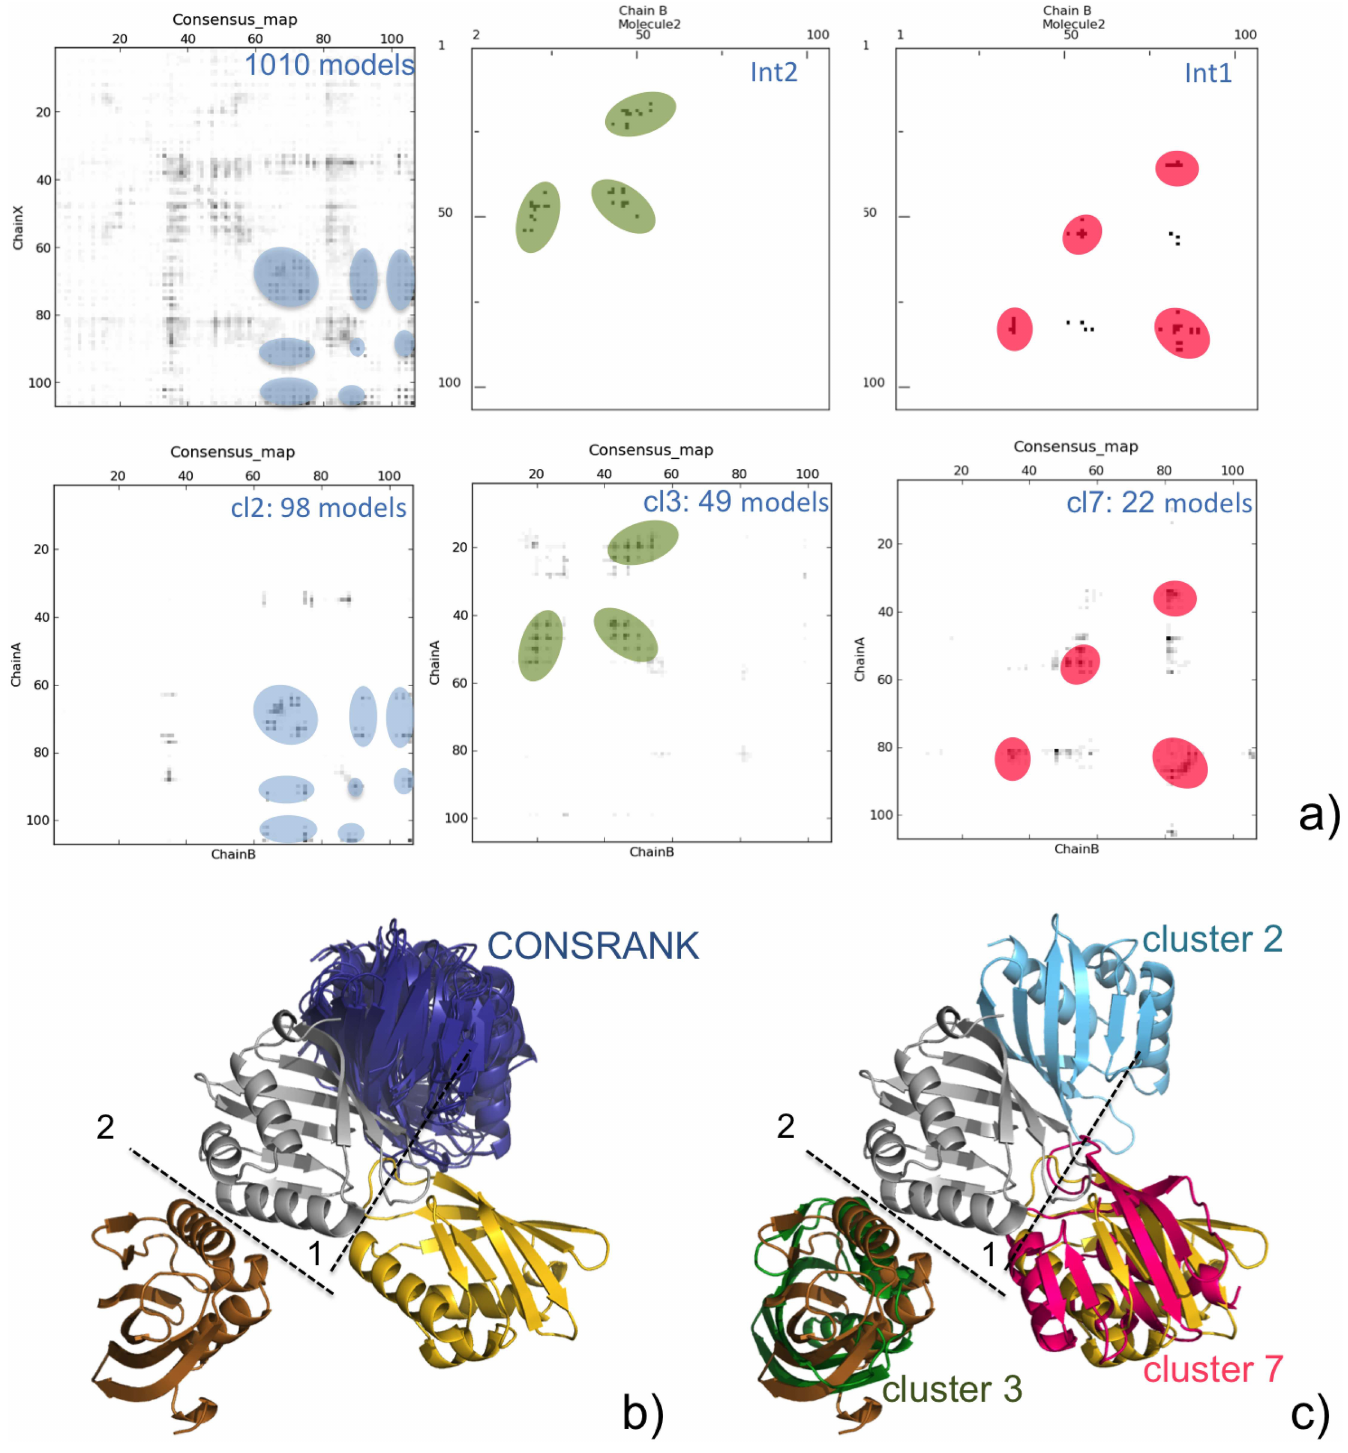
Fig 3. T86 scoring. (a) Consensusmap (from the 1010 models) and contact map of the two target assessedinterfaces (above) and consensus maps from the models in the 2 nd , 3 rd and 7 th MC /10 clusters (below).Regionshighlightedin the maps correspondto specific models/interfaces. For the color code, see below. ( b, c) 3D representation of the T86 target experimental structure and of selectedmodels by CONSRANK (b) and by Clust-CONSRANK—MC /10 (c). X-ray receptor is colored in silver, whilethe ligandat the interface 1 and 2 is coloredin gold and copper, respectively. Ligandsof models selectedby CONSRANK are colored deep blue, incorrect solutionsselectedby MC /10 are colored light blue, whilecorrect solutionsaccordingto interface 1 and 2 are colored hot pink and green, respectively. doi:10.1371/journal.pone.0166460.g003 PLOS ONE | DOI:10.1371/journal.pone.0166460 November15,